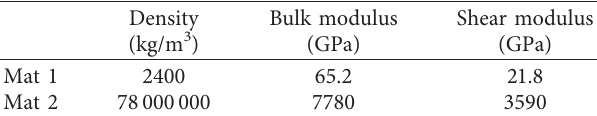
Table 1: Block parameters.